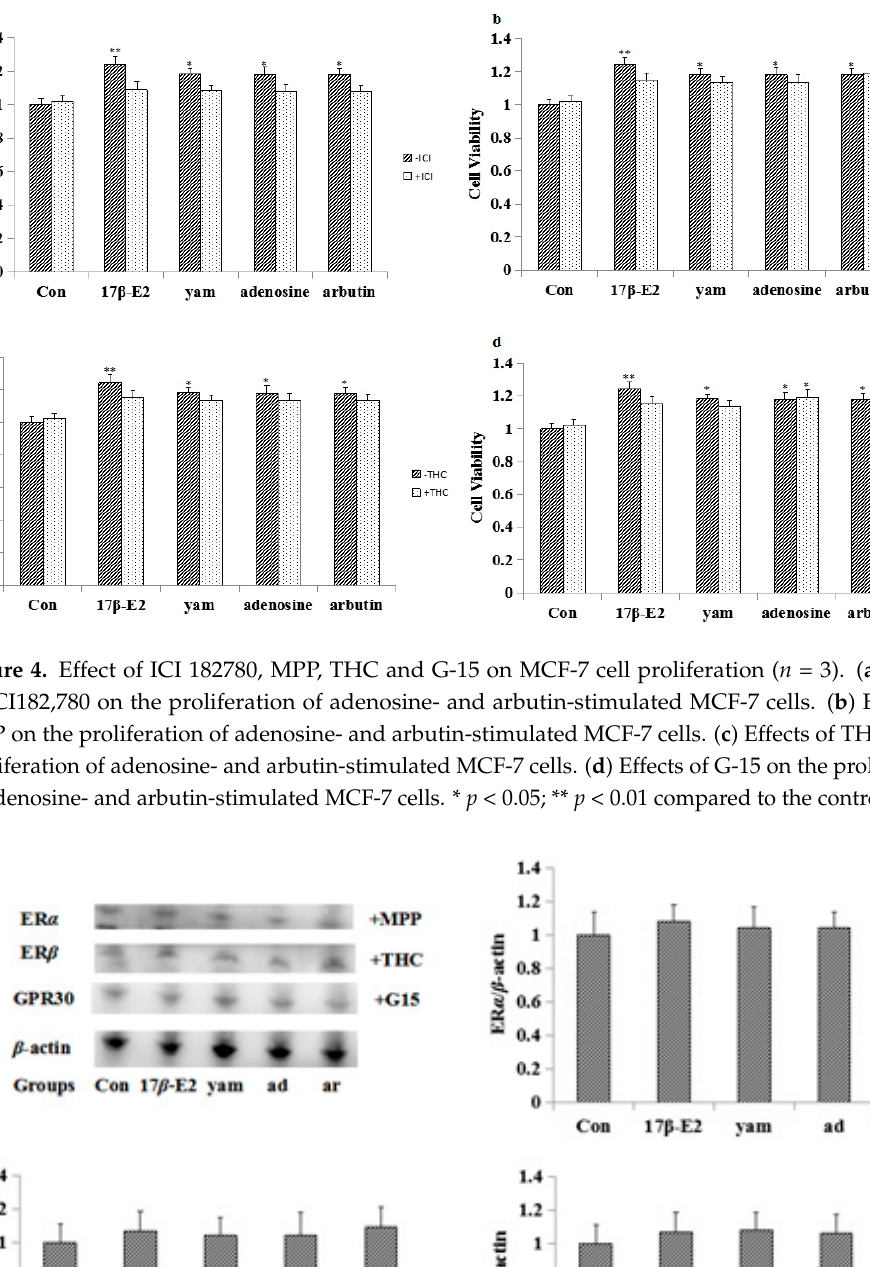
Table 5. Effect of mouse serum on the proliferation of MCF-7 cells (x ± SD, n = 4).